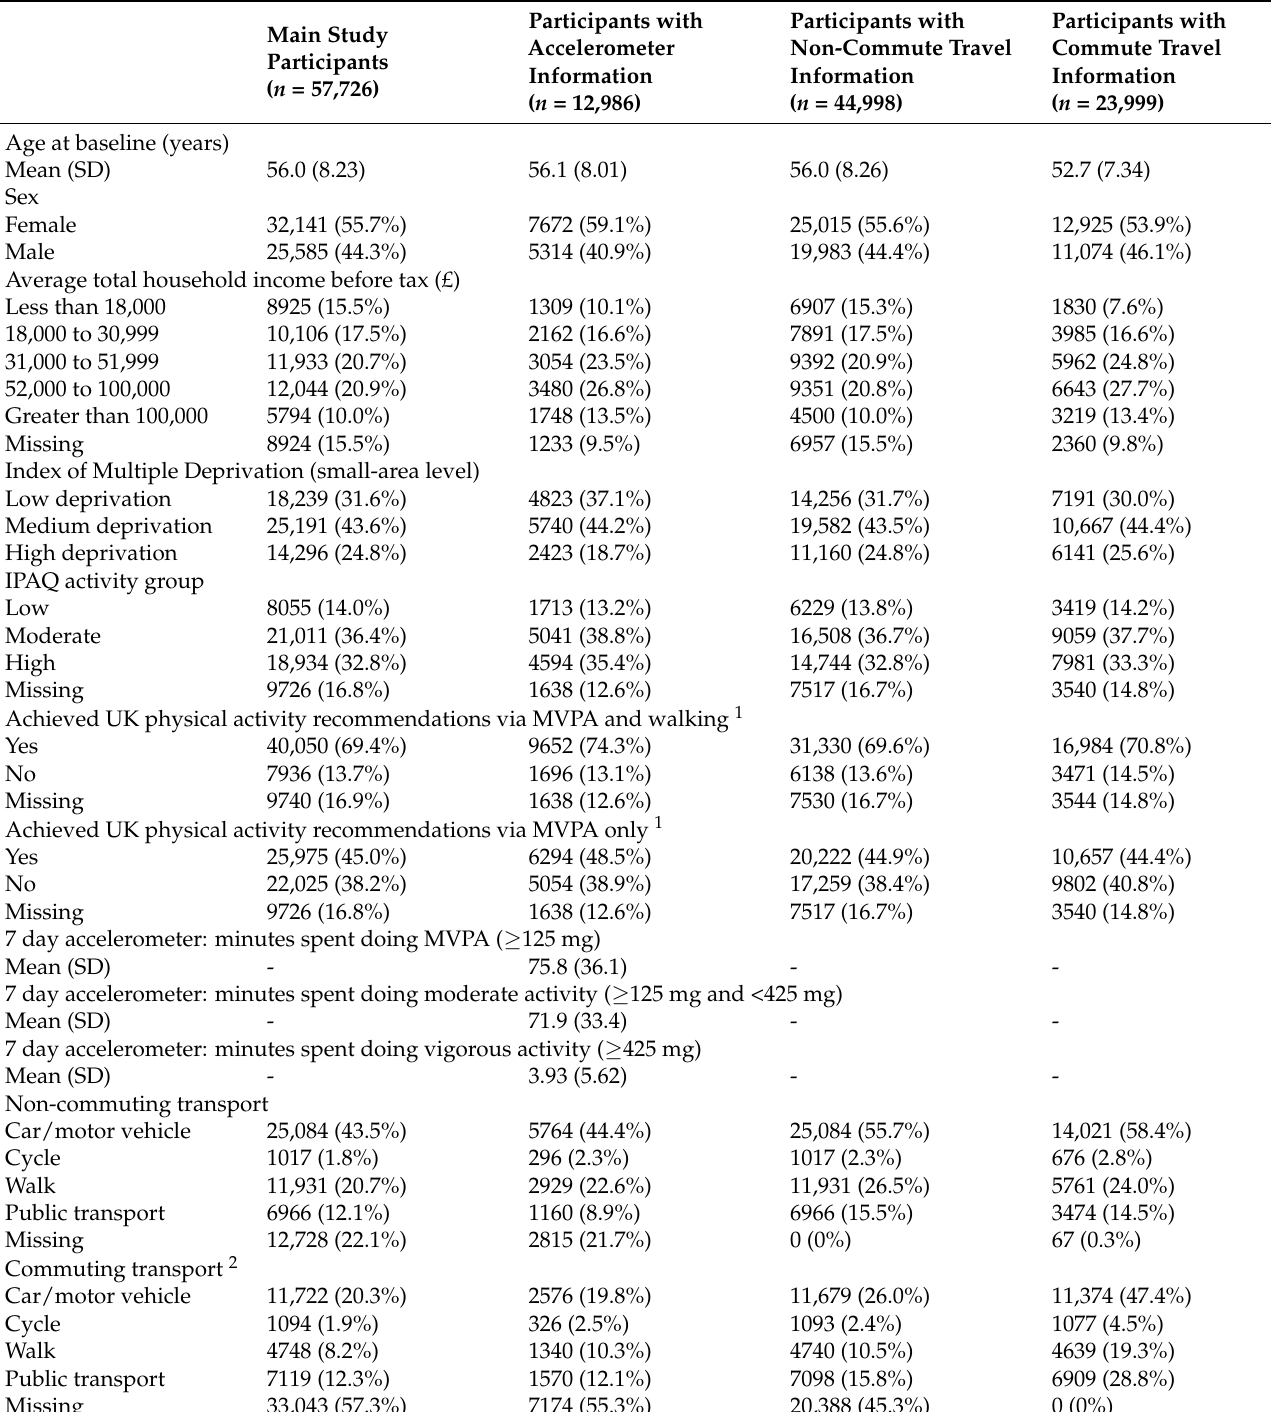
Table 1. Baseline characteristics of UK Biobank participants ( n = 57,726), participants with 7 day ac- celerometer information ( n = 12,986), participants with non-commute travel information ( n = 44,998), and participants with commute travel information ( n = 23,999); all study participants resided within Greater London administrative boundaries at study baseline